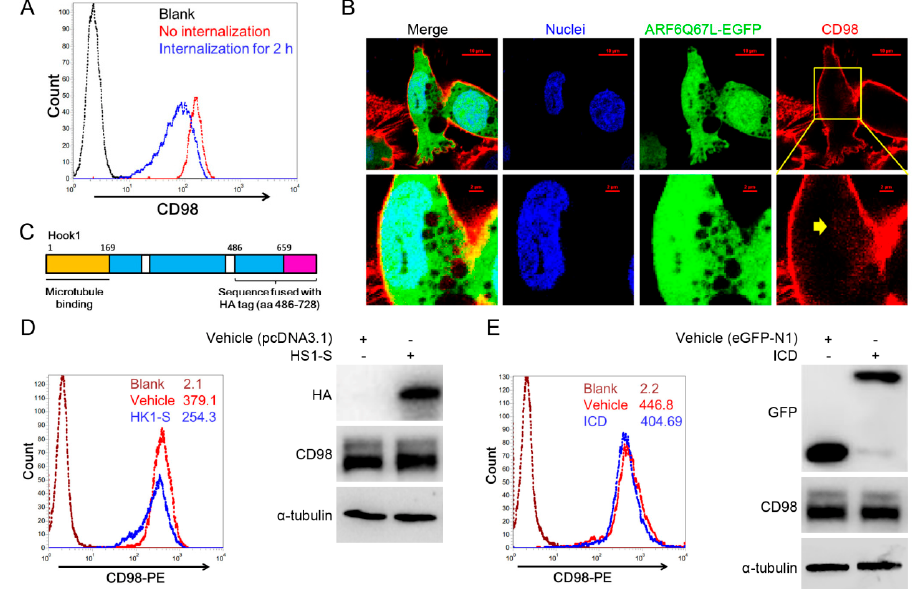
Figure 3. CD98-ICD was not directly involved in the recycling process of CD98. ( A ) Internalization of CD98. Subconfluent SMMC-7721 cells were incubated with anti-CD98 at 4 °C for 10 min, and then unbound antibodies were washed from the cells. Then, cells were allowed to internalize the surface label at 37 °C for 0–120 min. Bound antibodies were then labeled with Dylight 488 conjugated goat-anti-mouse secondary antibody and analyzed by FACS; ( B ) representative confocol microscopy images of CD98 (red) in SMMC-7721 cells transfected with ARF6Q67L–EGFP (green). Vacuolar membranes induced by ARF6Q67L: yellow arrow; CD98: red; Nuclei: blue. Bar, 10 μ m; ( C ) schematic representation of the domain organization of hook1 (the amino terminus is shown in yellow; aa 1–168, coiled-coil region in blue; aa 659–728, carboxyl terminus in pink). HK1-S encoding for aa 486–728 of hook1 was fused with an HA tag and used in subsequent experiments; ( D , E ) membrane CD98 was determined by FACS after SMMC-7721 cells were transfected with HK1-S or CD98-ICD for 36 h. The mean fluorescence intensity (MFI) of each group is indicated beside the histograms. The data shown are representative of three individual